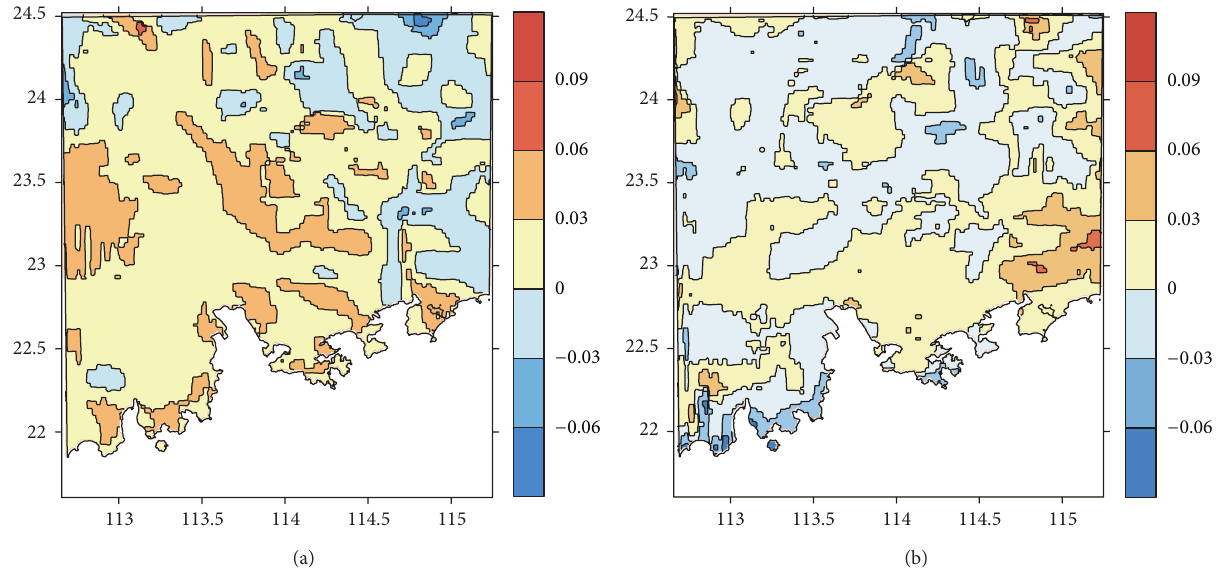
Figure 6: Spatial patterns of the change of 𝑇 2 (a) JJA; (b)